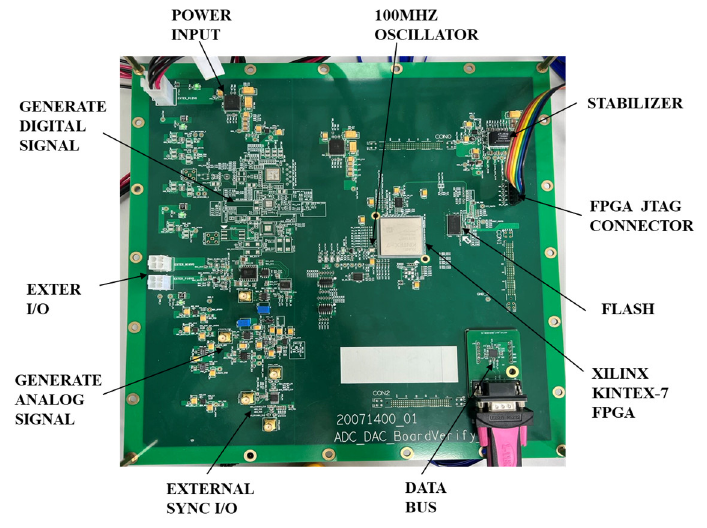
Figure 8. Test evaluation board.